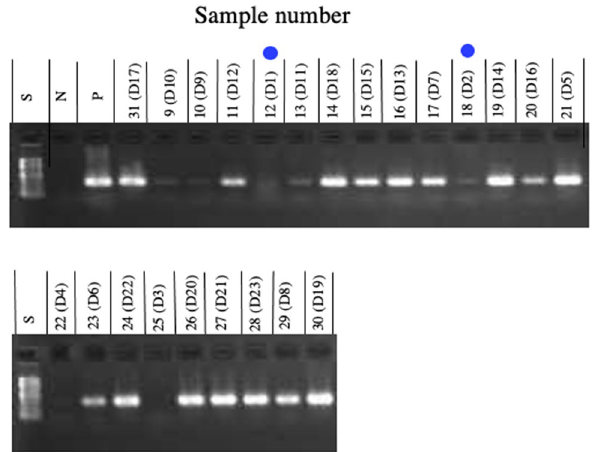
Figure 4. PCR to detect ctxA in the stool samples of diarrhea patients. DNA was extracted from the stool samples of 23 patients who were diagnosed with cholera disease. PCR to amplify ctxA in these DNA samples was performed using the specific primers ctcagacgggatttgttaggcacg and tctatctctgtagcccctattacg 6 , and the products were analyzed by agarose gel electrophoresis. The sample numbers are the same as the numbers shown in the footnotes of Fig. 3. Numbers beginning with D in parentheses show the order of the content of DNA from V. cholerae among these samples. The samples indicated by blue circle are samples from the diarrheal stools of patients (patients 12 and 18), who are focused on in this study. S: the size marker for gel electrophoresis; N: the negative control in which DNA was not added to the reaction mixture; P: the positive control in which DNA prepared from V. cholerae O1 N16961 28 was added to the reaction